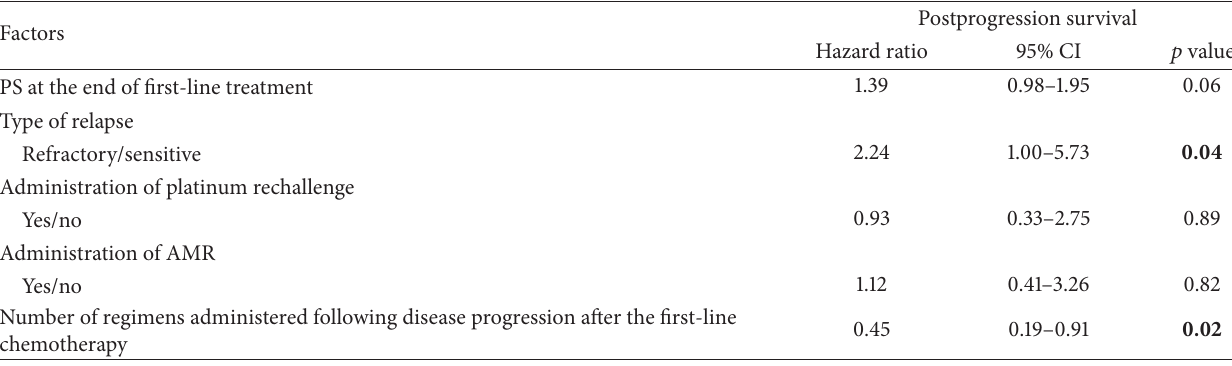
Table 4: Multivariate Cox regression analysis of PS at the end of first-line treatment, type of relapse, administration of platinum rechallenge, administration of AMR, and number of regimens administered following disease progression after the first-line chemotherapy for postprogression